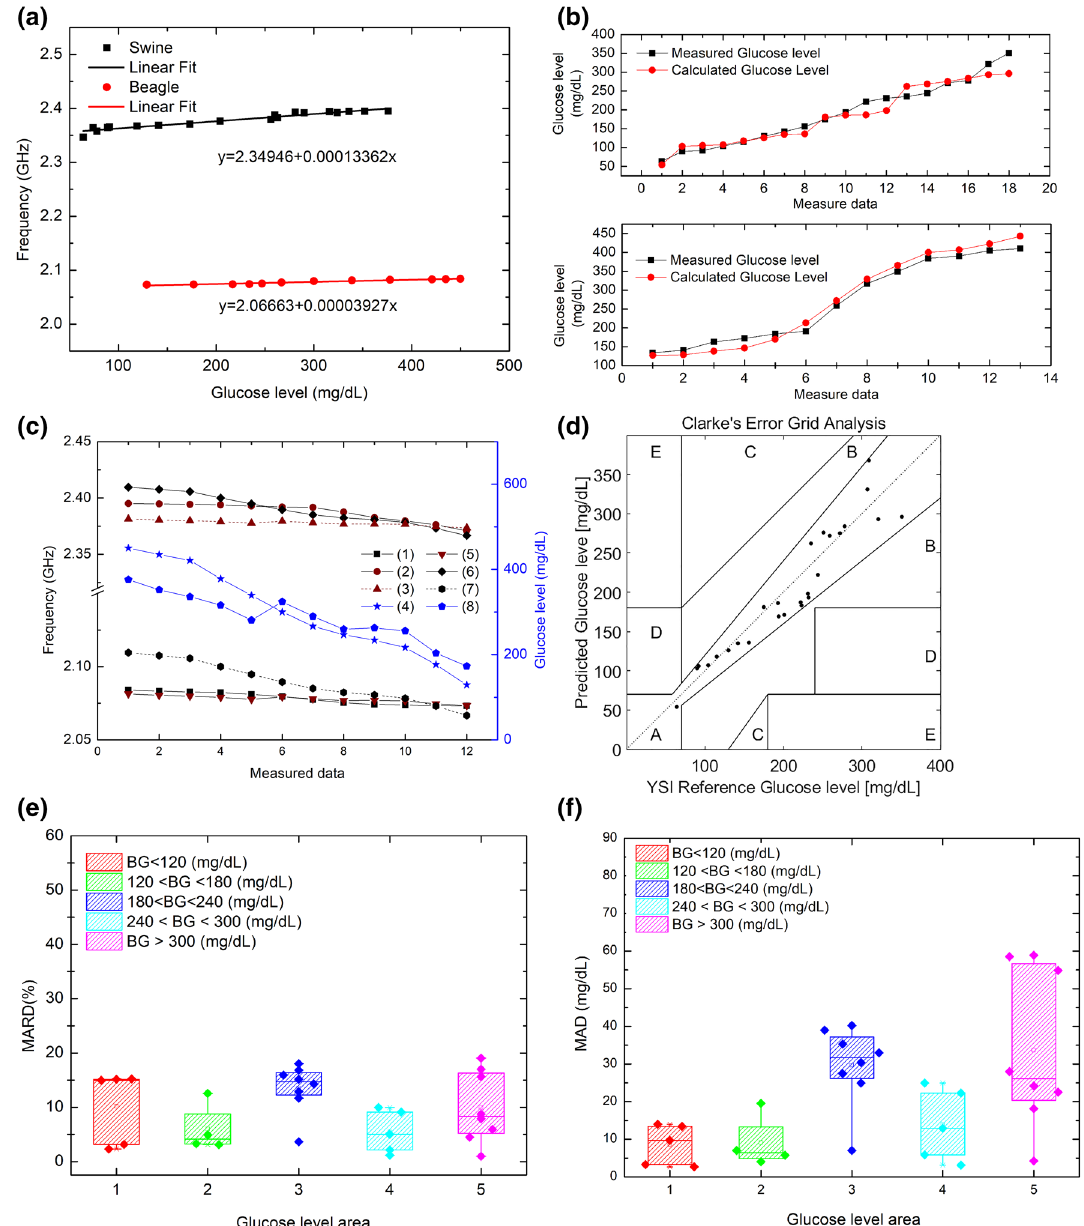
Figure 5. analysis results of Linear Regression, MARD, MAD, and EGA. ( a ) Analysis of linear regression about 2 = 0.92604 2 = 0.93399 swine ( R ) and beagle ( R ). ( b ) Compared between calculated BGL and reference BGL: (1) swine (upper) (2) Beagle (lower). ( c ) using regression equation of swine on beagle BGL measurement data and vice versa: (1) beagle measurement, (2) Swine measurement (3) Swine data offset (4) Beagle Glucose level (5) Swine Calculation (6) Beagle calculation (7) Beagle data offset (8) Swine Glucose level. ( d ) EGA for the beagle and swine (Zone-A: 92.31% n = 24, Zone-B: 7.69% n = 2, Zones-C, D, E: 0%). ( e ) Change in MARD values according to the glucose level areas (n = 30). ( f ) Comparison between reference BGL and predicted BGL. The distribution (n = 30) was determined by dividing the glucose level into five glucose level areas. (1) The average value of MAD was 8.6119 in the standard BGL range (BG < 120 mg/dL, n = 5). (2) The average MAD value was 9.0977 for the glucose level area of pre-diabetes and diabetes (120 < BG < 180 mg/dL, n = 4). (3) The average MAD value was 17.2447 in the glucose level area of diabetes (180 < BG < 240 mg/dL, n = 8). (4) The average MAD values of the high-risk and hyperglycemia groups (240 < BG < 300 mg/dL, n = 5 BG > 300 mg/dL, n = 8) were 12.6545 and 33.6701 mg/dL,